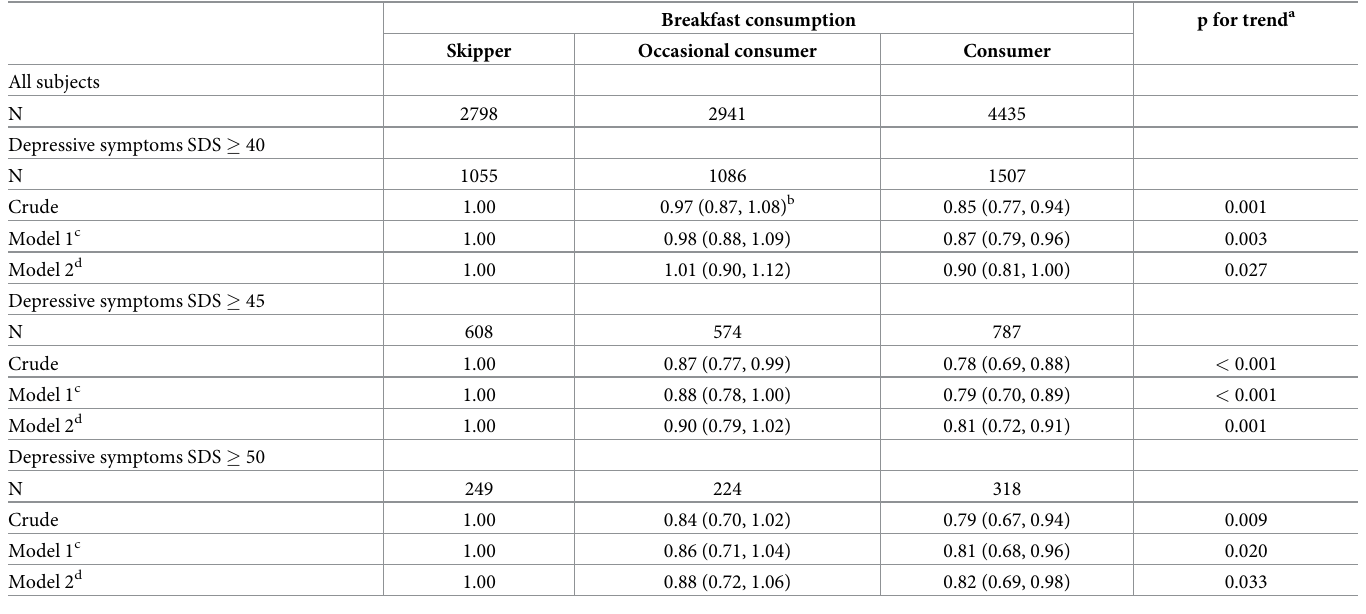
Table 2. Adjusted associations between frequency of breakfast consumption and depressive